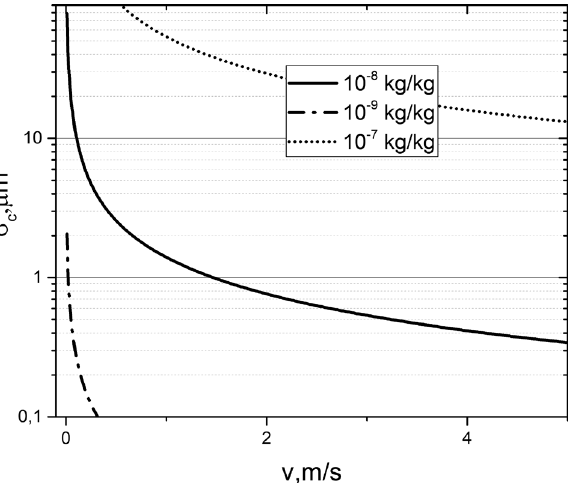
Figure 8. Calculated results and experimental data for oxide film growth based on static and dynamic experiments for steel EP-823 (Balbaud-Celerier et al. 2004). The calculated error is 55% for a dynamic experiment and 30% for a static.